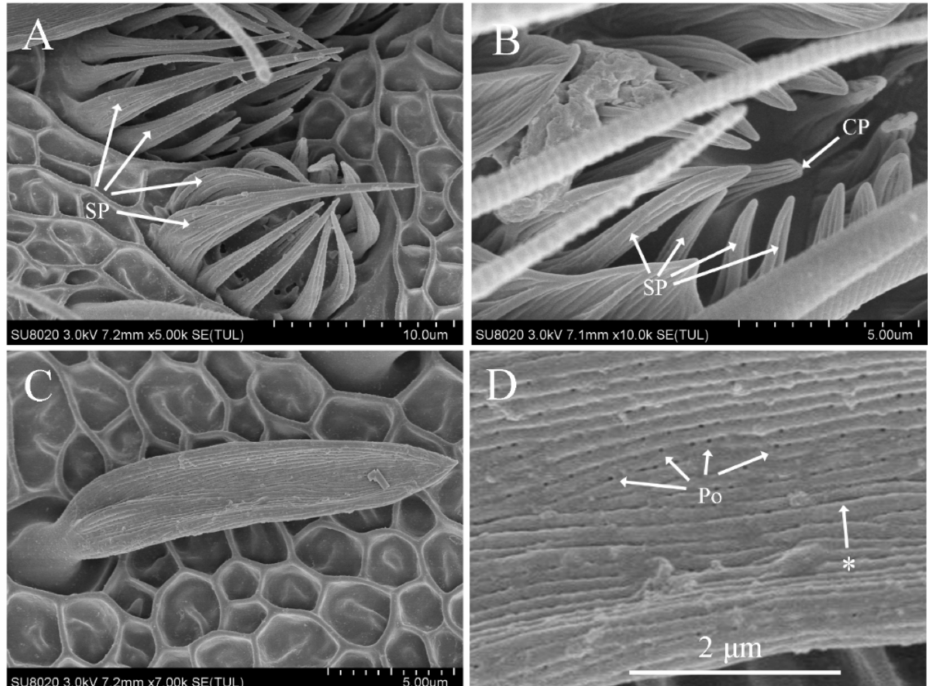
Figure 2. Scanning electron micrographs of sensilla coeloconica and auricillica on the antennae of Dioryctria rubella . ( A ) Sensilla coeloconica; ( B ) close-up of sensilla coeloconica; ( C ) sensilla auricillica; ( D ) close-up of sensilla auricillica. Arrow with the asterisk indicates the longitudinal grooves on the sensillum surface. CP, central peg; SP, spine-like protrusions; Po,